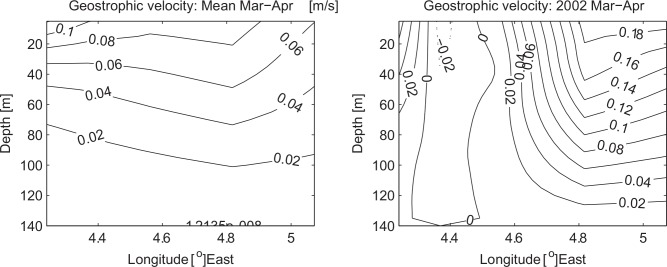
Baroclinic velocity field based on hydrographic sections over the continental shelf in the Svinøy section during the March and April 1986–2013.(Left) Mean velocities based on 47 sections and (right) velocity in 2002 which was a peak recruitment year based on two sections. The estimates are based on the assumption of a layer of zero velocity at 140 m which is nearly the depth of the shallowest station. Positive values means velocities northward and stations closest to the coast are to the right in the figures.